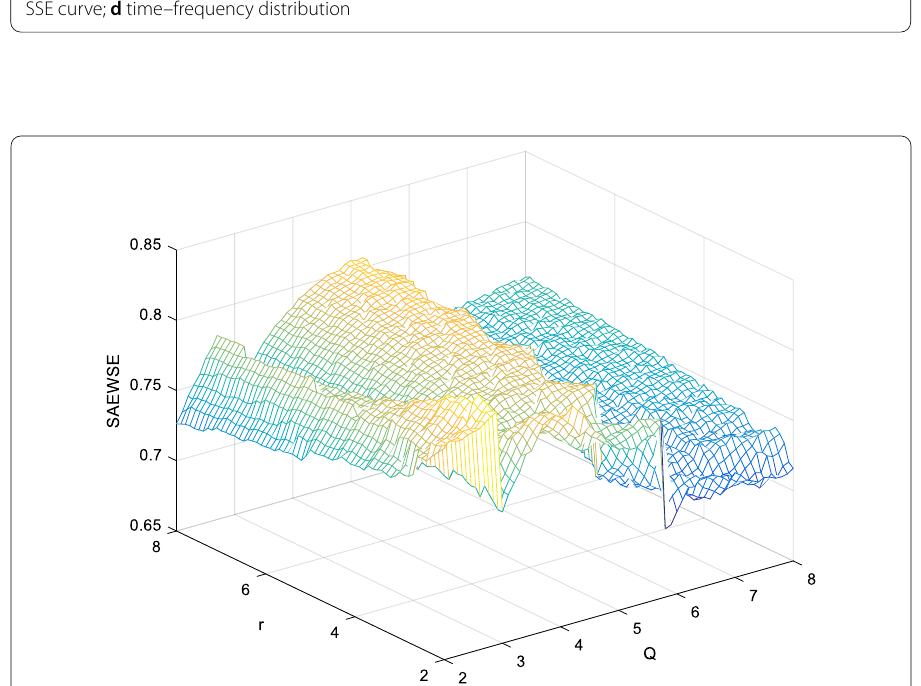
Fig. 11. 3d curve of adaptive parameter optimization. The figure shows the SAEWSE value in the two-dimensional grid search space of parameter (Q,r), the optimal parameter ( Q opt = 6.2, r opt = 8 ) is determined according to the minimum value of SAEWSE